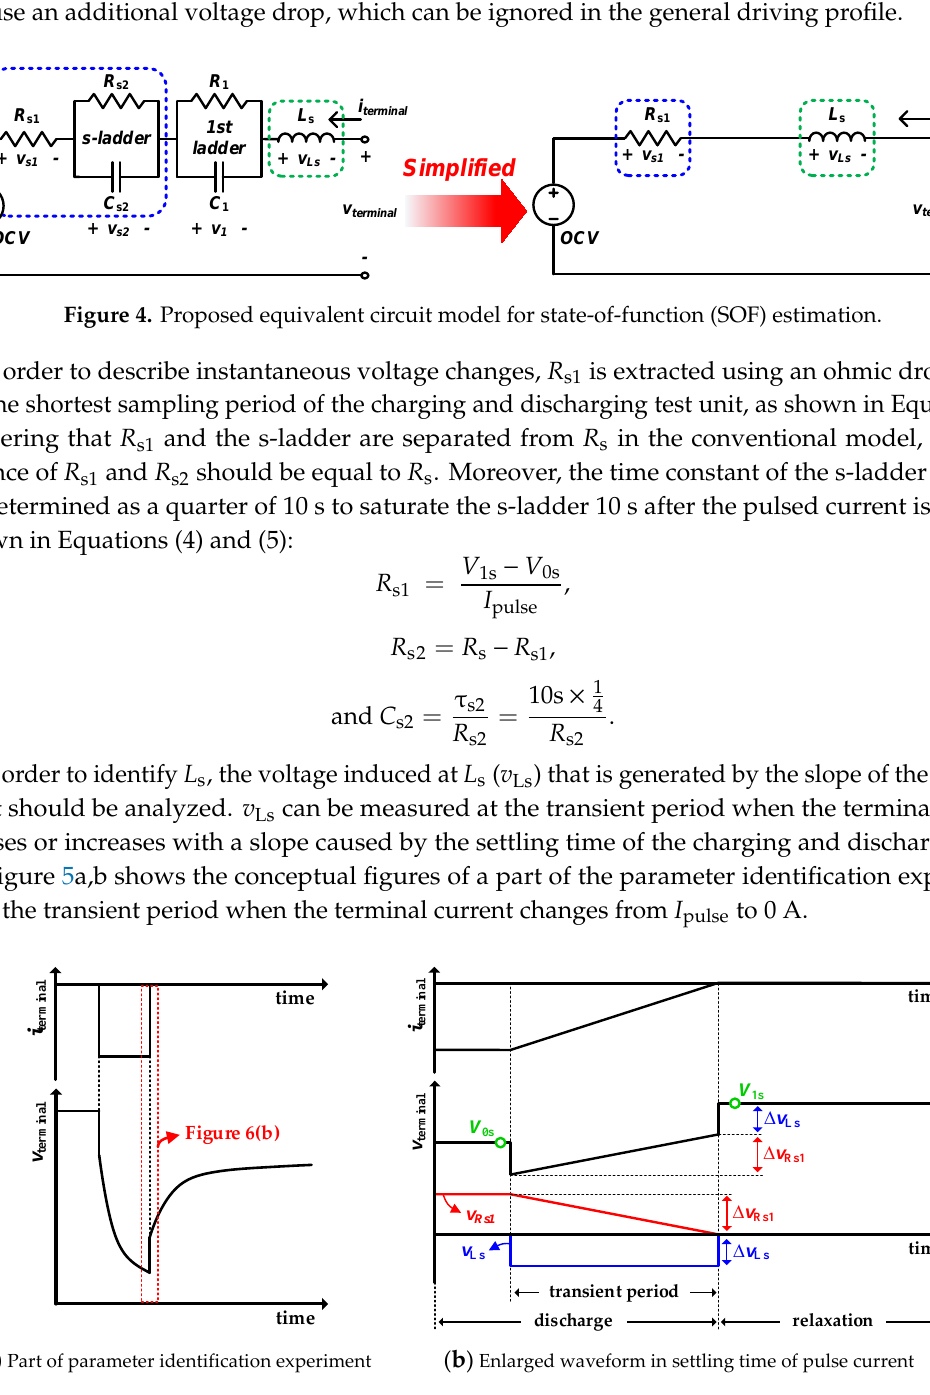
Figure 5. Conceptual figure of strategy for identification of L s .